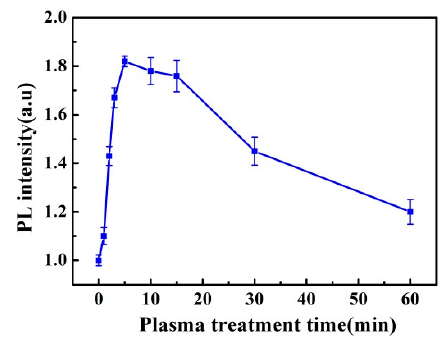
Figure 3. The influence of plasma treatment time on PL intensity.